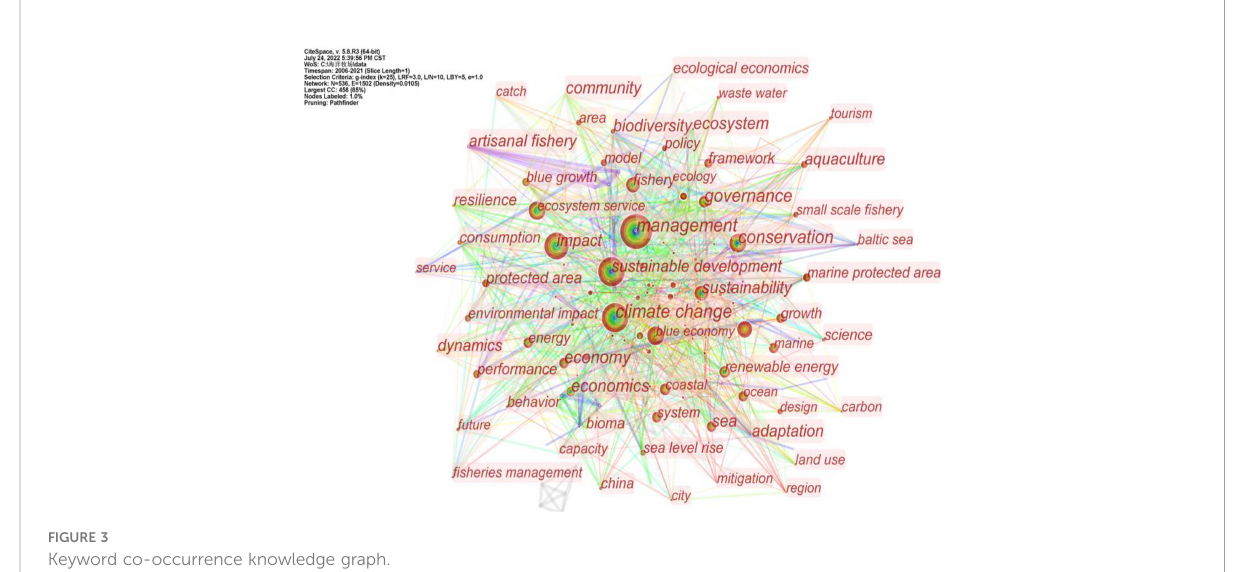
FIGURE 3 Keyword co-occurrence knowledge graph.